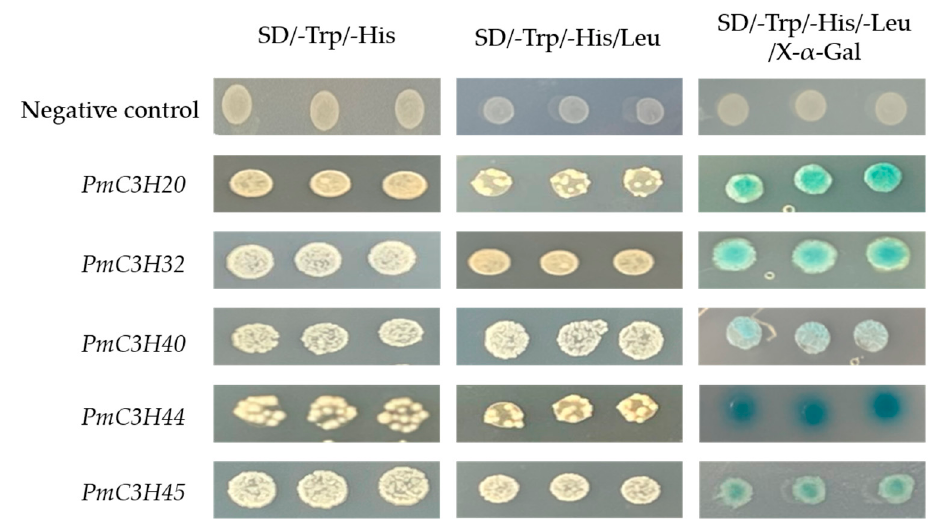
Figure 7. Transcriptional activation assay of five RR-TZF genes. Empty pGBKT7 vector was used as a negative control.